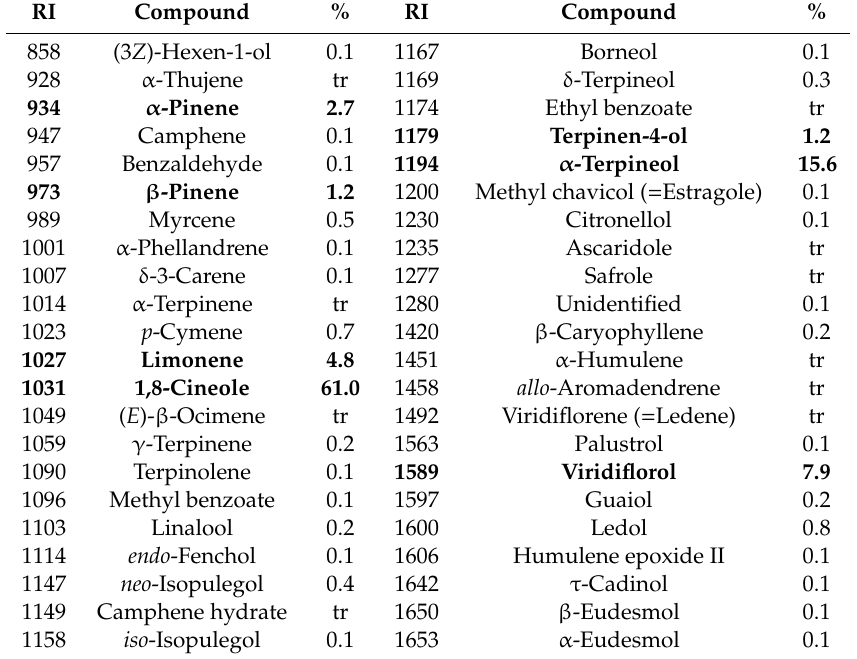
Table 1. Peak assignment for gas chromatography-mass spectrometry profiles of the essential oil extracted by hydrodistillation from Melaleuca leucadendra collected in National Botanic Garden, Havana,